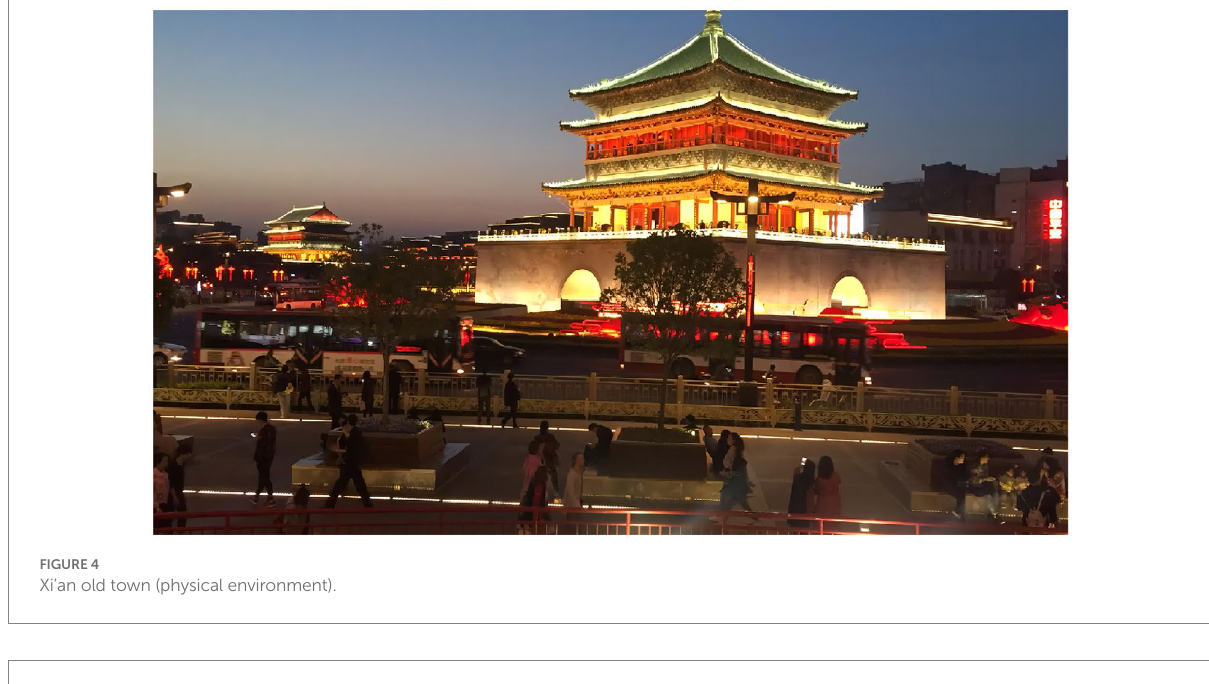
FIGURE 4 Xi’an old town (physical environment).